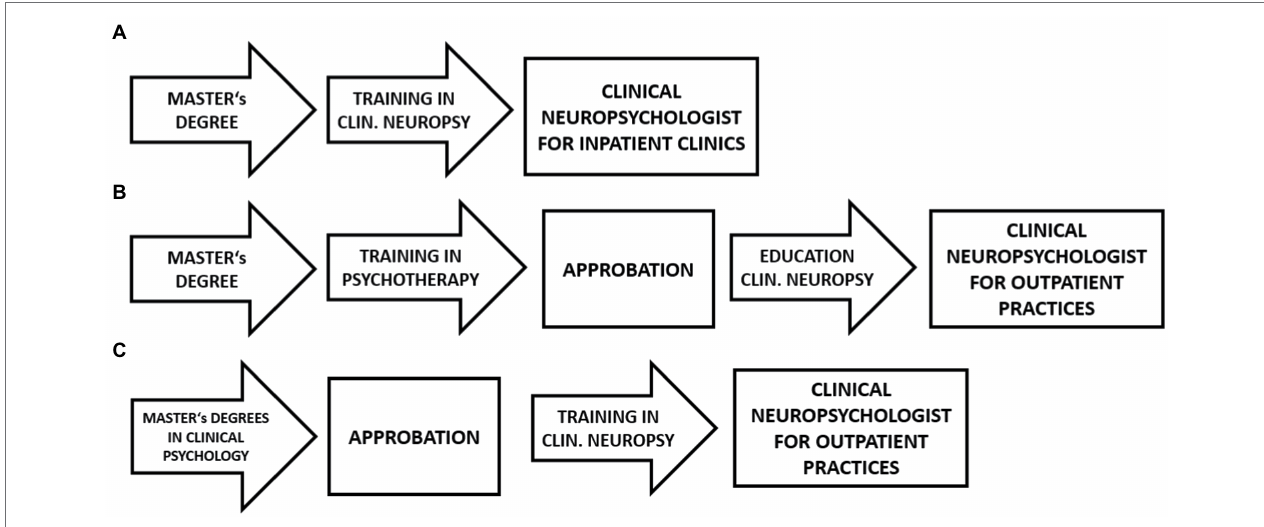
FIGURE 2 | (A) Current training pathway for neuropsychologists in inpatient clinical settings. (B) Current training pathway for neuropsychologists working in their own practices. (C) Planned training pathway for clinical neuropsychologists working in their own practices. Approbation = state accreditation as a doctor or